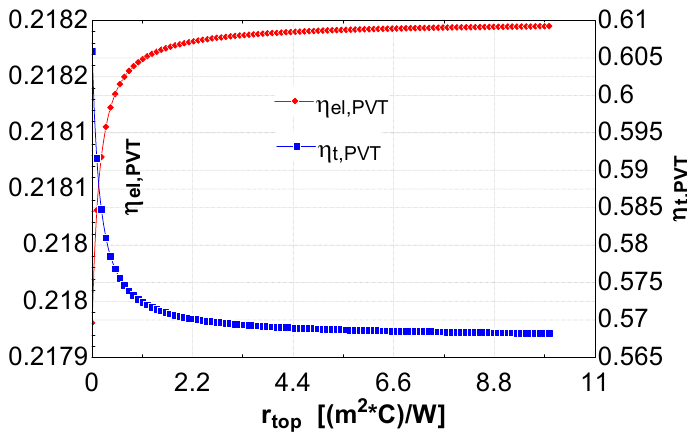
Figure 14. CPVT thermal and electrical efficiency vs. top thermal resistance.